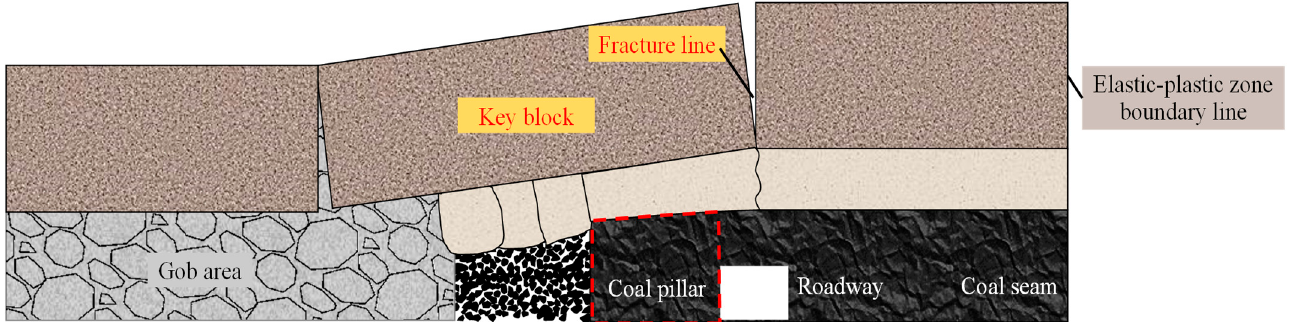
Figure 15. Structure model with main roof fracture line above the solid coal [53].